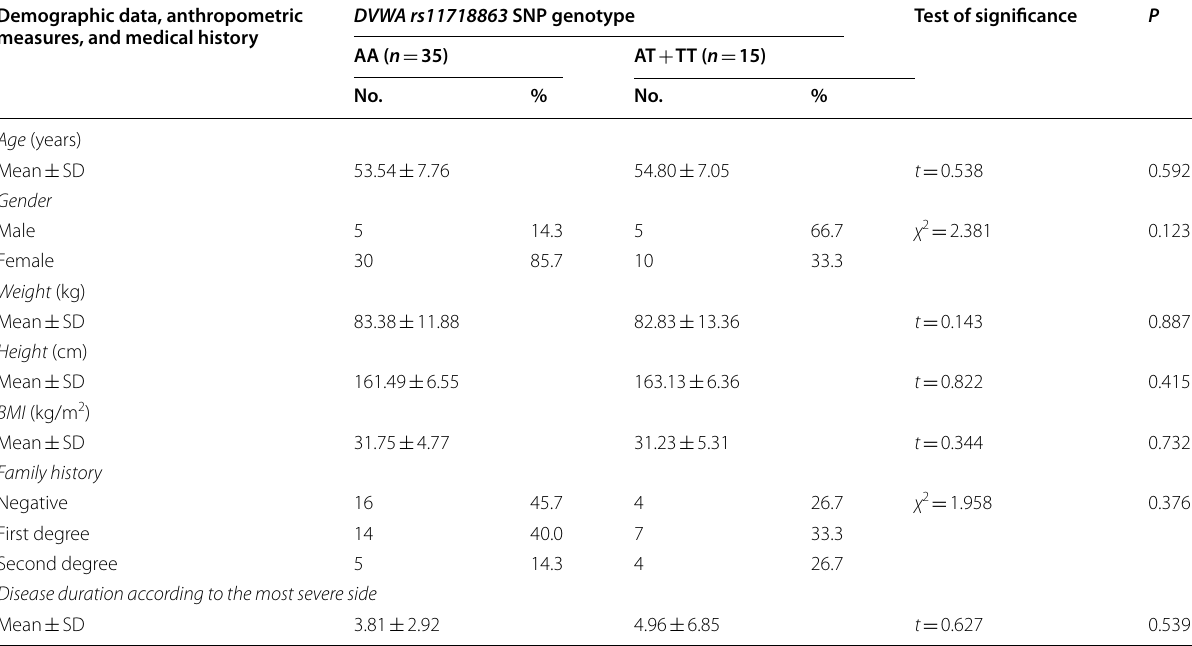
Table 3 Relation between DVWA rs11718863 single nucleotide polymorphism and demographic data and anthropometric measures in patient group